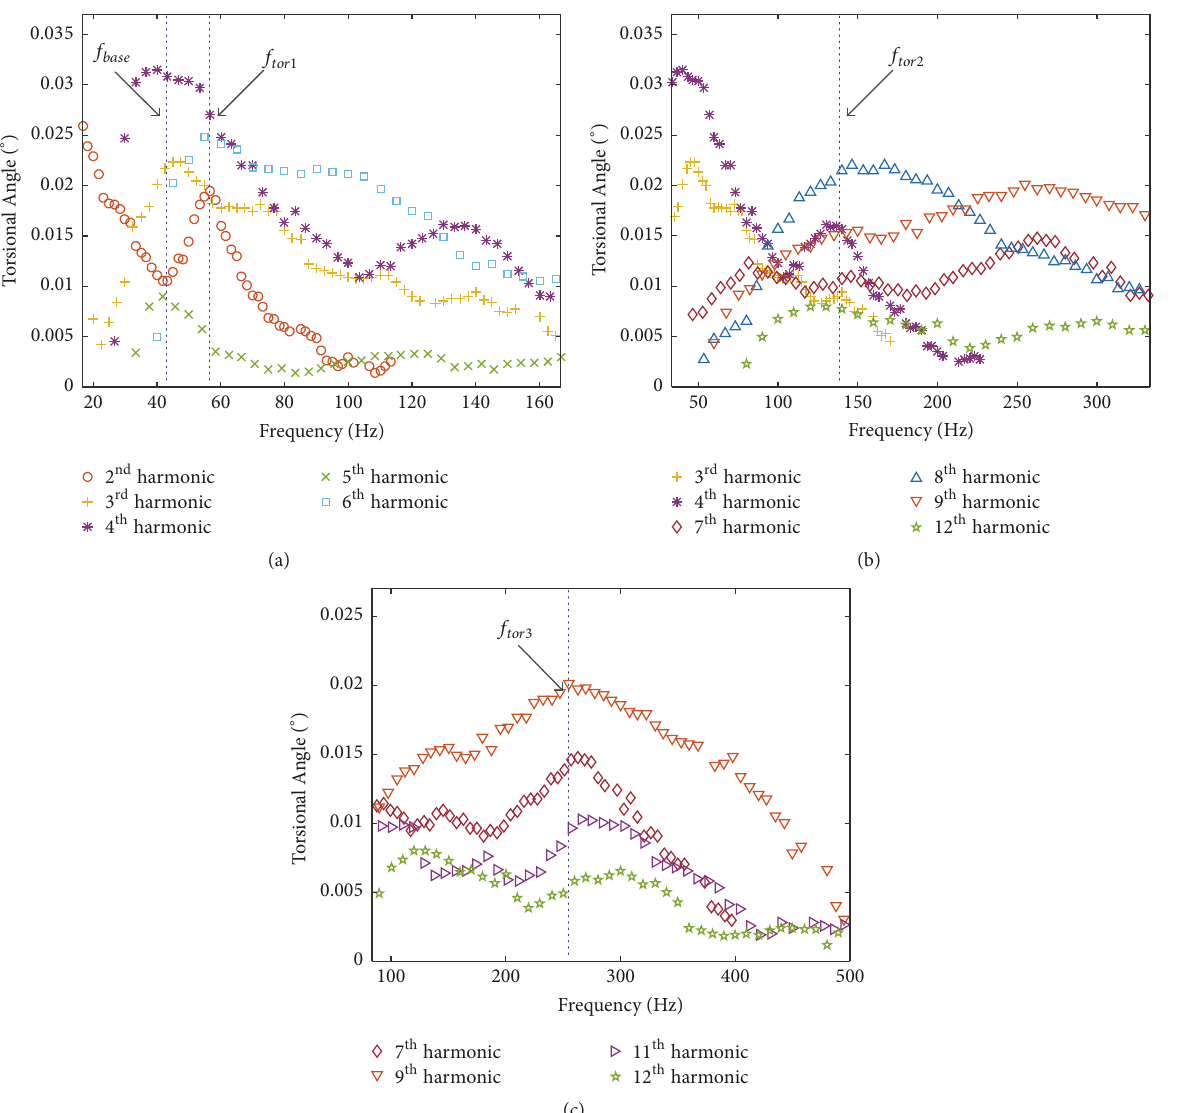
Figure 15: Torsional vibration response and torsional natural frequency: (a) 2nd through 6th harmonic, (b) 3rd, 4th, 7th, 8th, 9th, and 12th harmonic, and (c) 7th, 9th, 11th, and 12th harmonic. Table 5: Comparison of the torsional natural frequencies between calculation and test. Mode